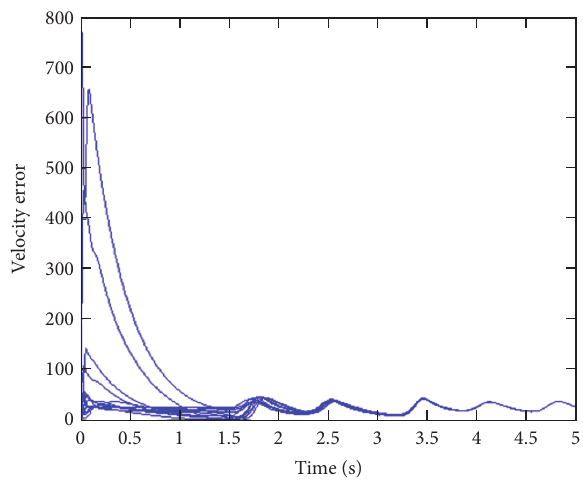
Figure 3: The inertial nodes’ velocity error